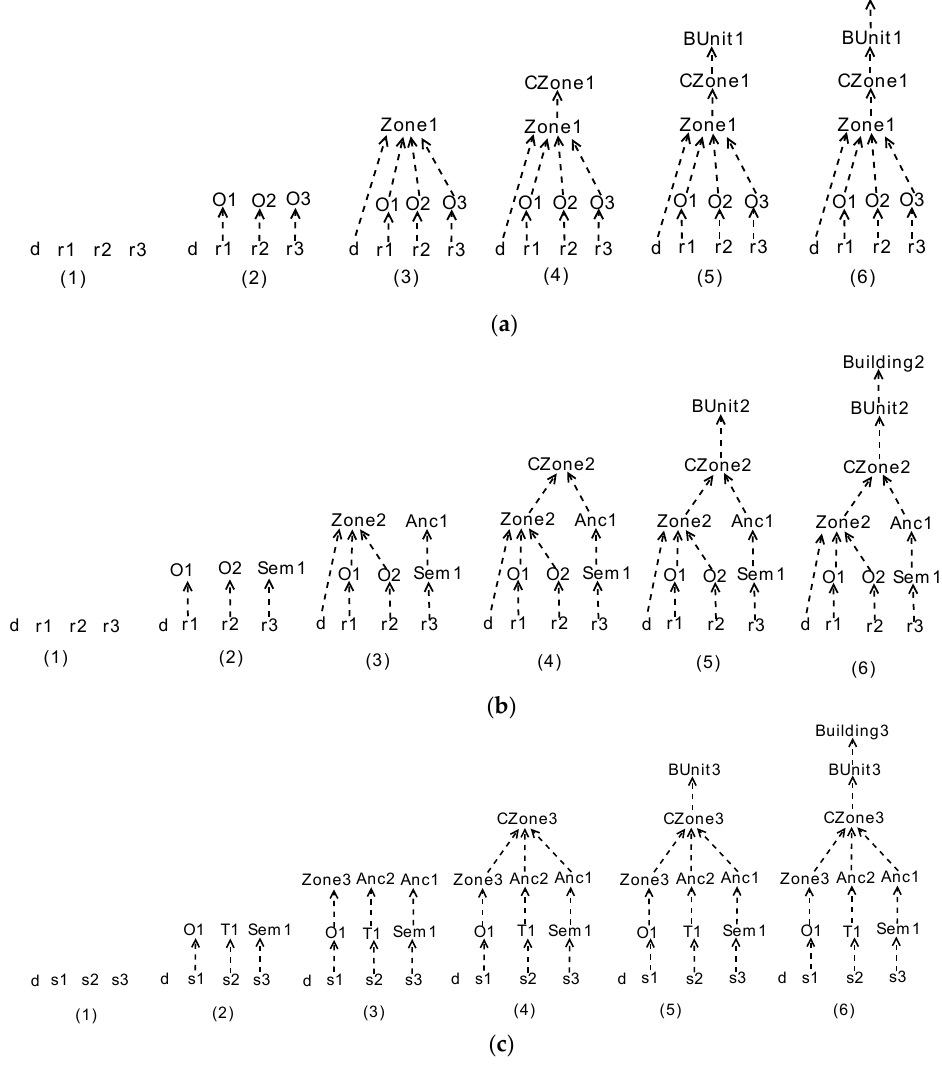
Figure 7. Procedure of creating parse forest by using bottom-up methods. ( a ) procedure of constructing first parse tree ( b ) procedure of constructing second parse tree ( c ) procedure of constructing third parse tree.